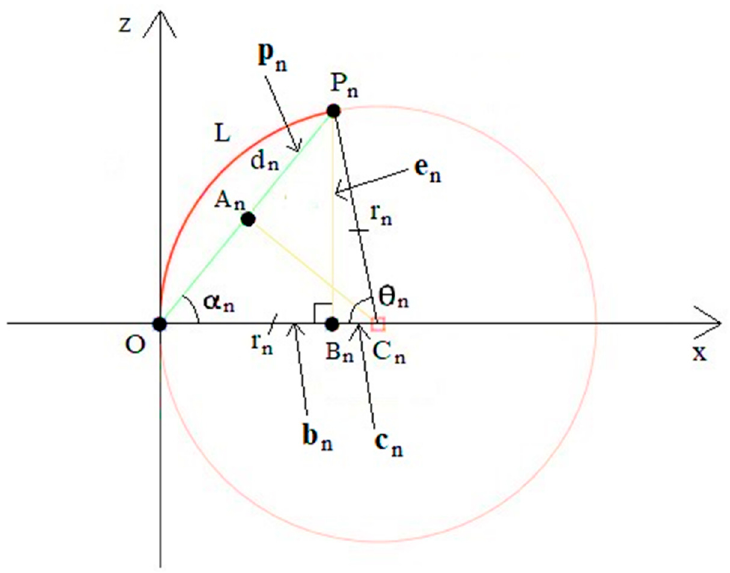
Figure 6. Robot segment in the 2D workspace x ‒ z plane (the segment form is in a regular circle arc shape). d n —chord length ( n —segment number); r n —arc radius ( n —segment number); L —circle arc length; O —arc start point; P n —arc endpoint ( n —segment number); C n —circle center point ( n —segment number); A n —middle point of the OP n straight line ( n —segment number); α n —angle between p n and c n vectors ( n —segment number); θ n —arc angle ( n —segment